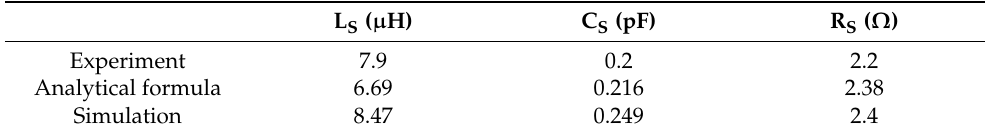
Table 3. Results of spurious parameters.